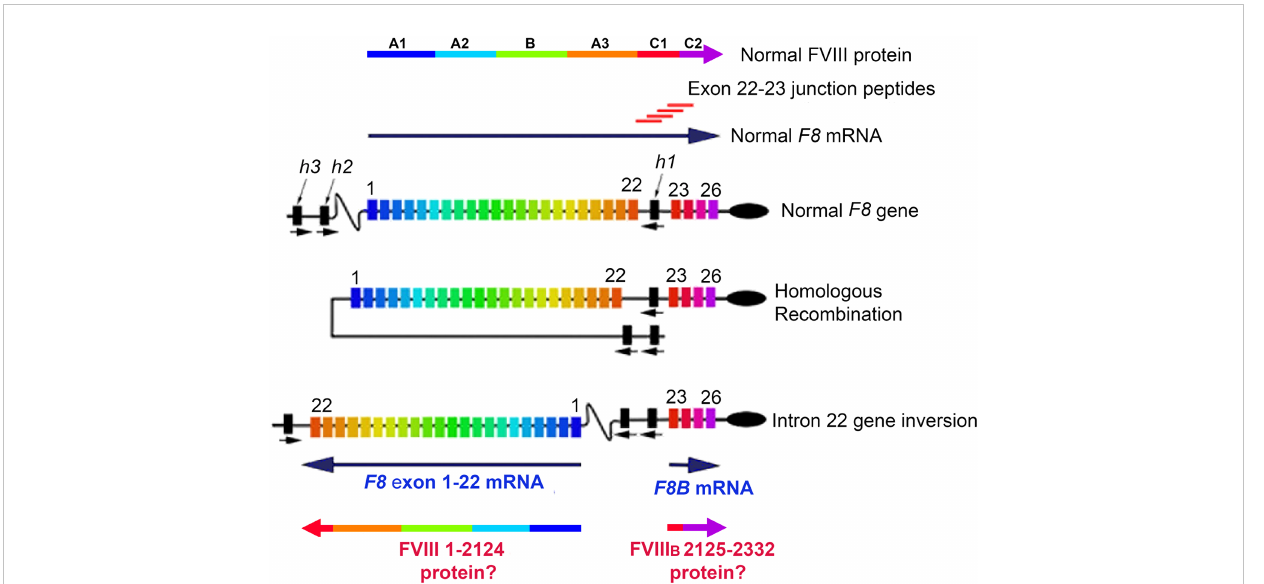
FIGURE 1 FVIII Structure, Int22Inv DNA, Int22Inv mRNA, and hypothesized partial FVIII proteins. Full-length FVIII consists of domains A1, A2, A3, B, C1 and C2, which are encoded by the 26-exon F8 gene. Following a type 1 or type 2 intron 22 inversion mutation, the primary F8 mRNA product consists of F8 exons 1-22, which encode the FVIII A1, A2 and B domains, plus the C1 domain sequence through M2124 and then terminating at a stop codon within intron 22. The shorter transcript F8B is comprised of 24 nucleotides followed by F8 exons 23-26, which encode FVIII residues 2125-2332. If these two partial FVIII proteins were expressed intracellularly, this could in principle promote tolerance to FVIII as a “ self ” -protein. The 20-mer exon 22-23 junction peptides, with F8 sequences overlapping by 12 residues, were designed to allow peptides to bind to the HLA-DRB1 binding grooves in multiple possible registers, in order to evaluate their potential ability to be presented to CD4 + T